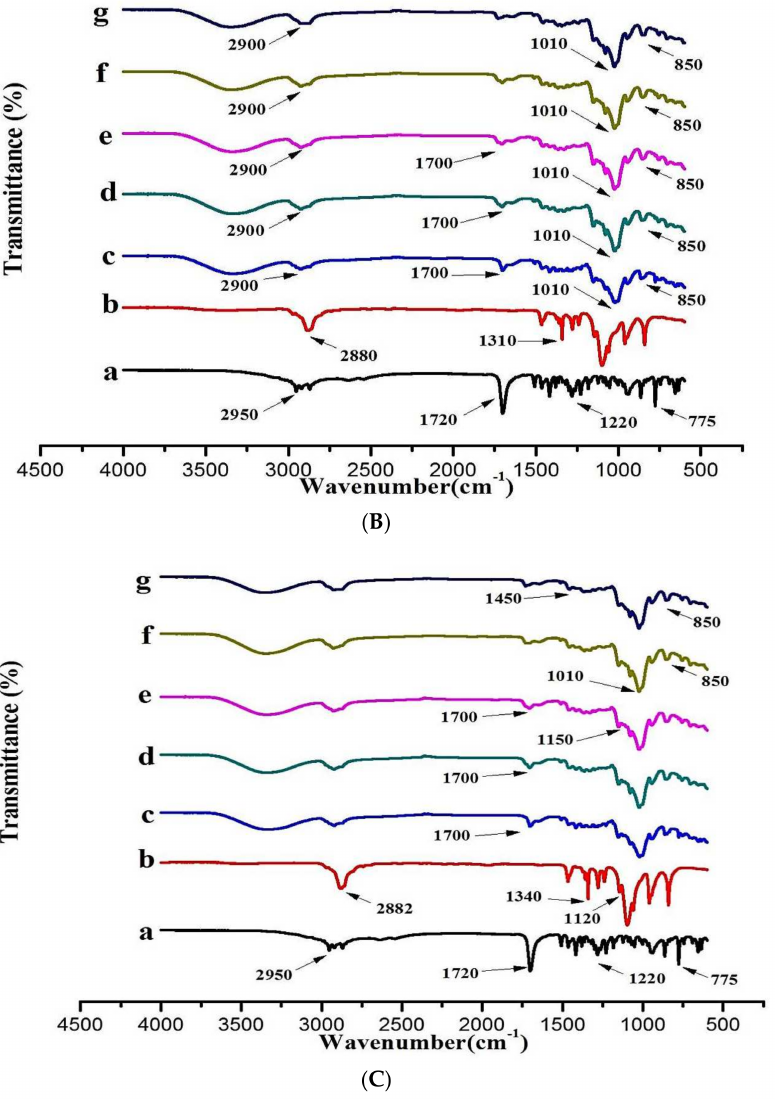
Figure 5. ( A ) FTIR spectrum of (a) DEX, (b) HP β CD, (c) DEX/HP β CD (1:1), (d) DEX/HP β CD (1:2) and (e) DEX/HP β CD (1:4) prepared by kneading method. ( B ) FTIR spectrum of (a) DEX, (b) PXM − 188, (c) 1:4 DEX:HP β CD, (d) 1:4 DEX:HP β CD:PXM − 188 2.5%, (e) 1:4 DEX:HP β CD:PXM − 188 5.0%, (f) 1:4 DEX:HP β CD:PXM − 188 10% and (g) 1:4 DEX:HP β CD:PXM − 188 20%. ( C ) FTIR spectrum of (a) DEX, (b) PXM − 407, (c), 1:4 DEX:HP β CD, (d) 1:4 DEX:HP β CD:PXM − 407 2.5%, (e) 1:4 DEX:HP β CD:PXM − 407 5.0%, (f) 1:4 DEX:HP β CD:PXM − 407 10% and (f) 1:4 DEX:HP β CD:PXM − 407